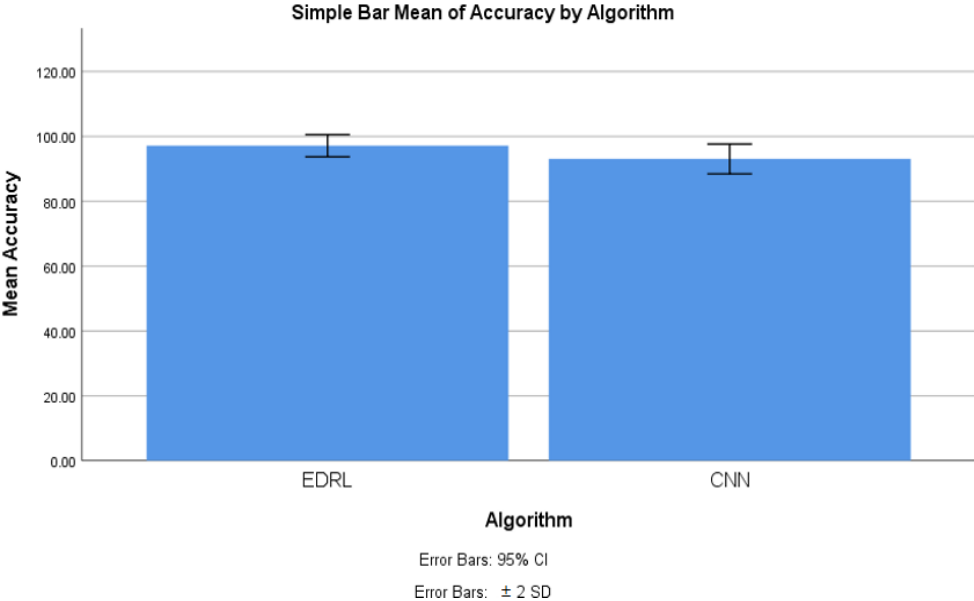
Figure 3. Mean accuracy comparison of EDRL and CNN, including error rates.